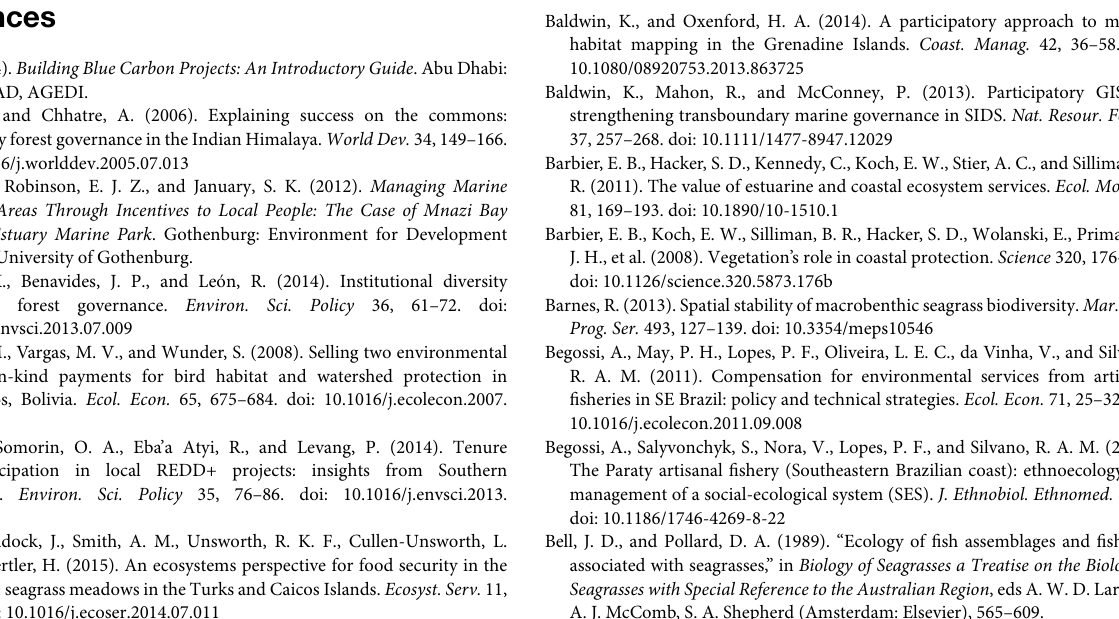
Table S1 | Ecosystem Service Valuation Methods. Table S2 | PES schemes with a carbon management